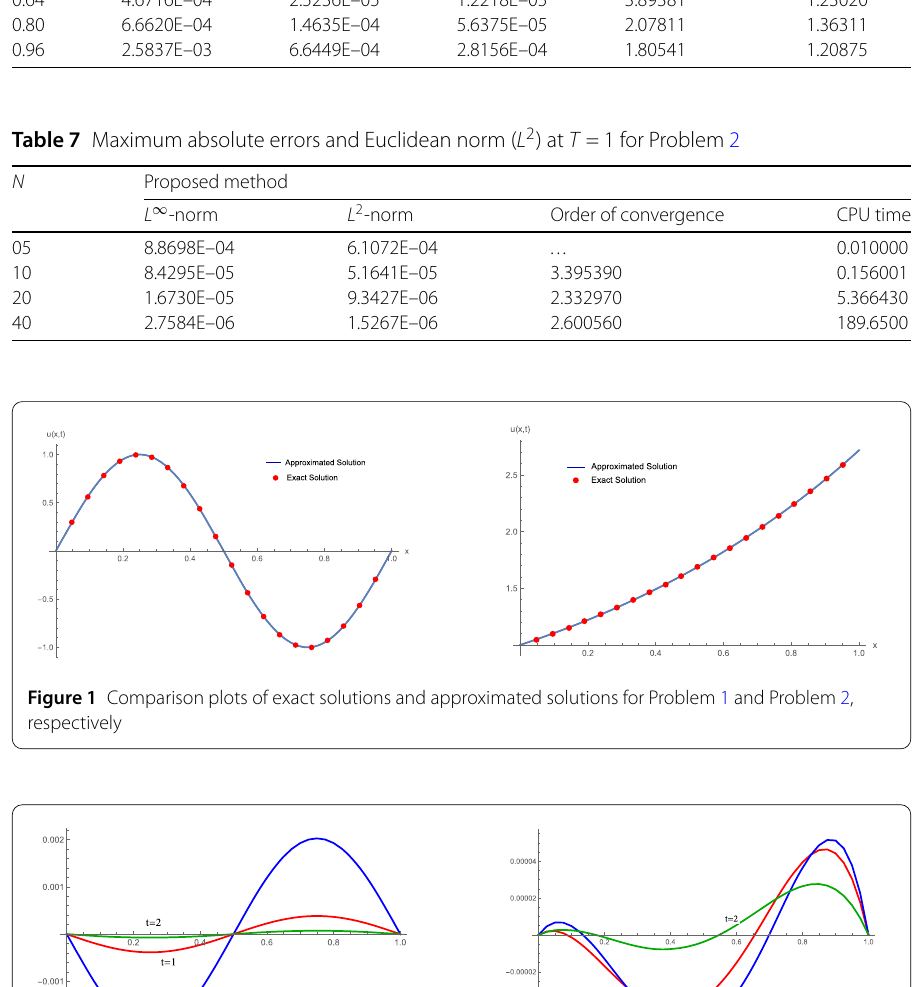
Table 6 A comparison of L 2 -norm with h = 1